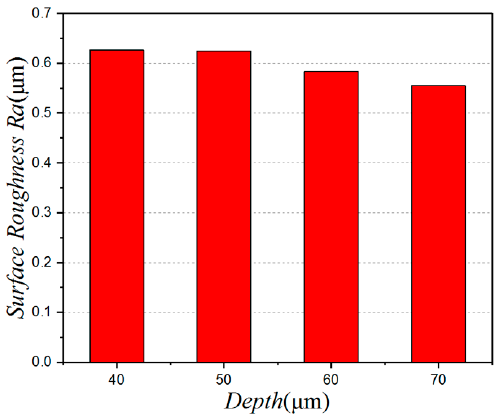
Figure 7. The relationship between the depth and the surface roughness.